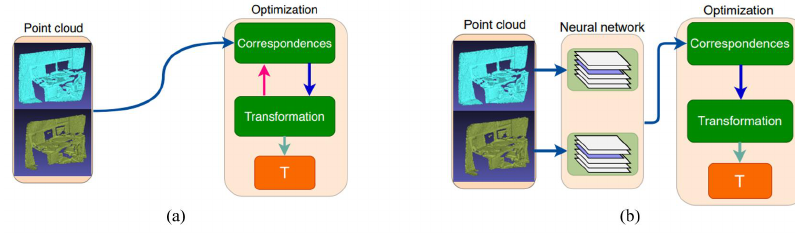
Figure 1. ( a ) Classic optimization-based method. ( b ) Learning-based